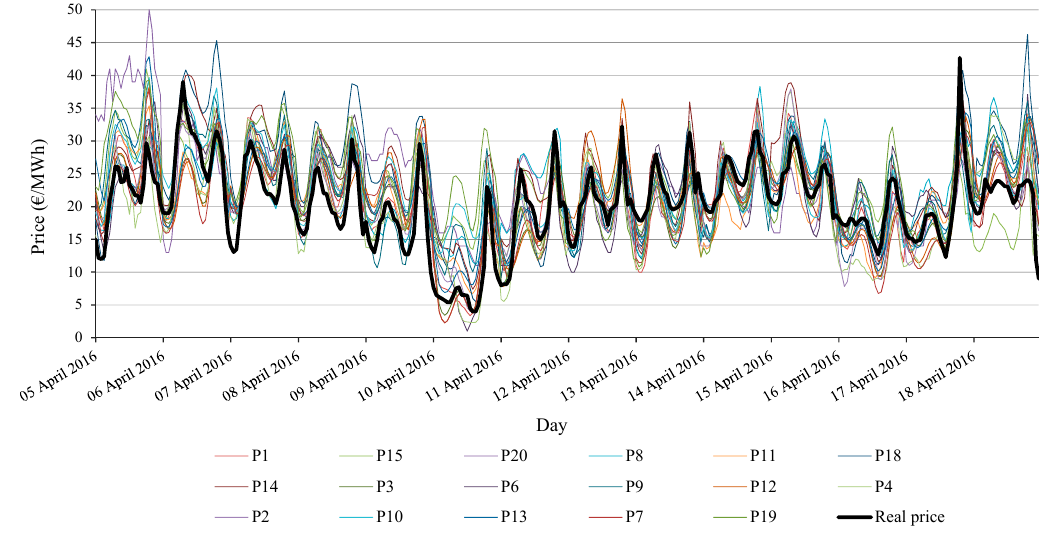
Figure 5. Forecasts provided by the twenty best predictors and hourly real prices.